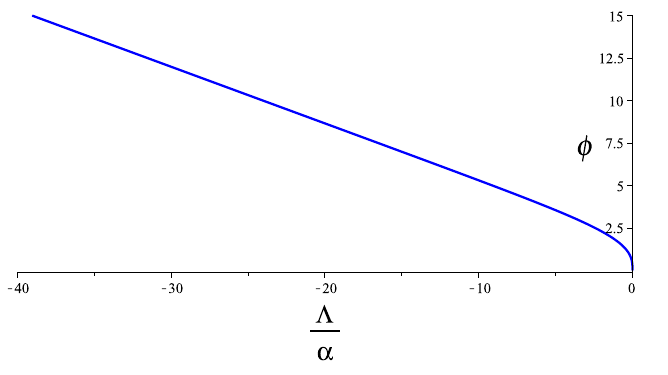
Figure 8 . The curve shows the points where the (cid:12)rst derivative dV=d(cid:30) vanishes. For any (cid:3) the potential develops a global minimum for some (cid:30) >